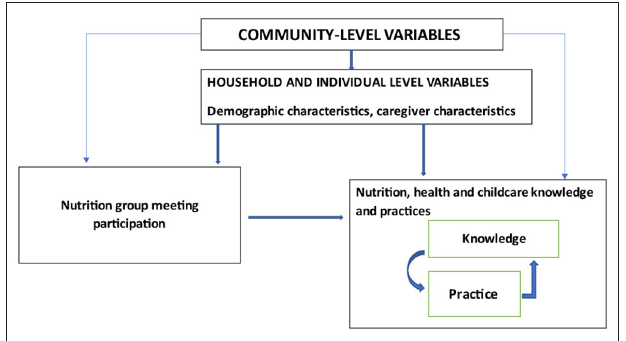
FIGURE 1 | Conceptual framework of the association between participation in nutrition group meetings and knowledge and practices of caregivers of young children. Adopted from Perumal et al.